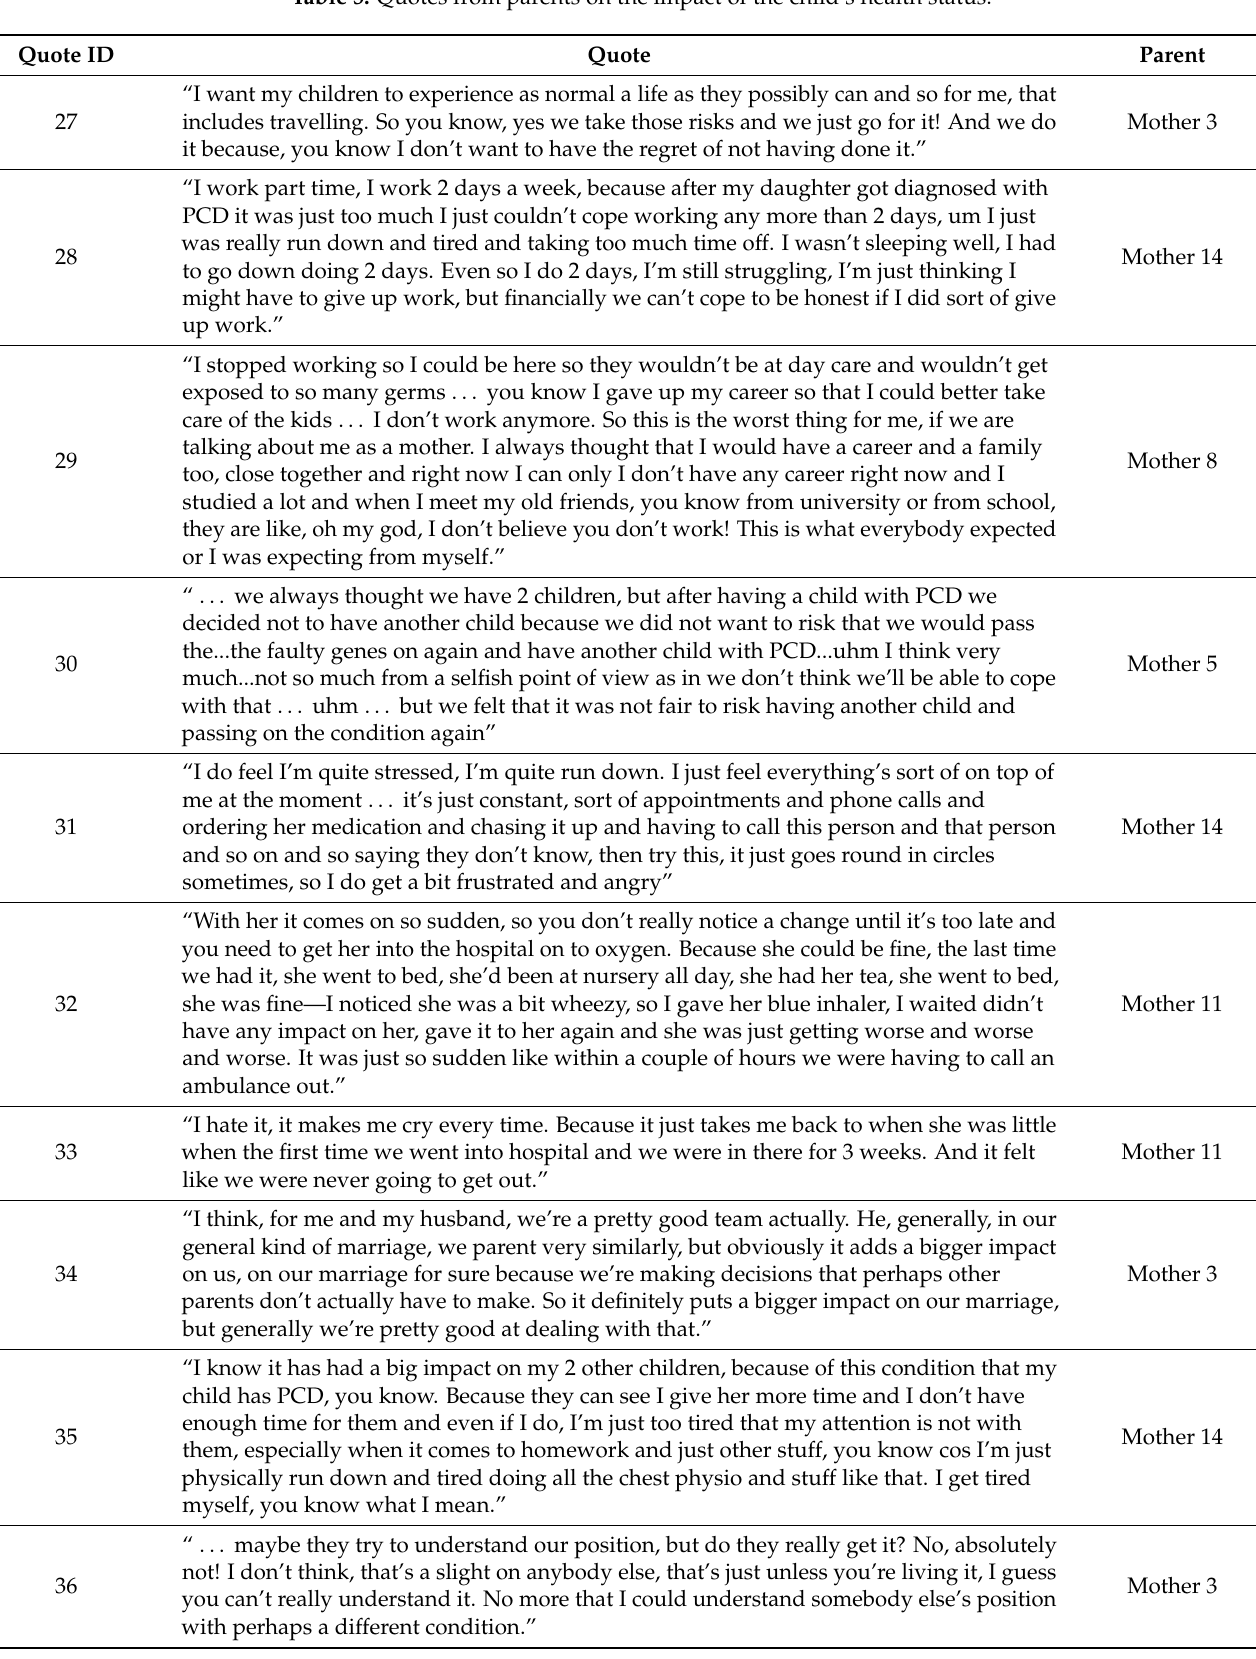
Table 5. Quotes from parents on the impact of the child’s health